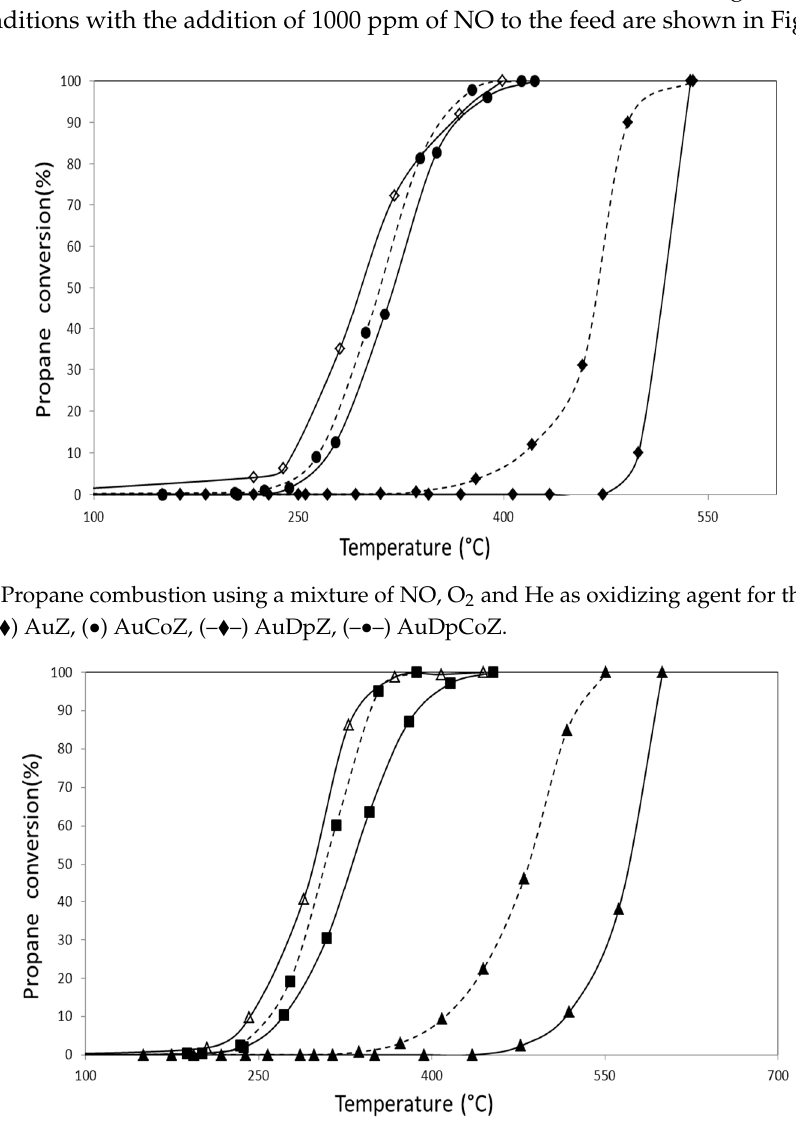
Figure 10. Propane combustion using a mixture of NO, O 2 and He as oxidizing agent for the catalysts ( Δ ) CoZt,( ▲ ) AuZt, ( ■ ) AuCoZt, (-- ▲ --) AuDpZt, (-- ■ --) AuDpCoZt.